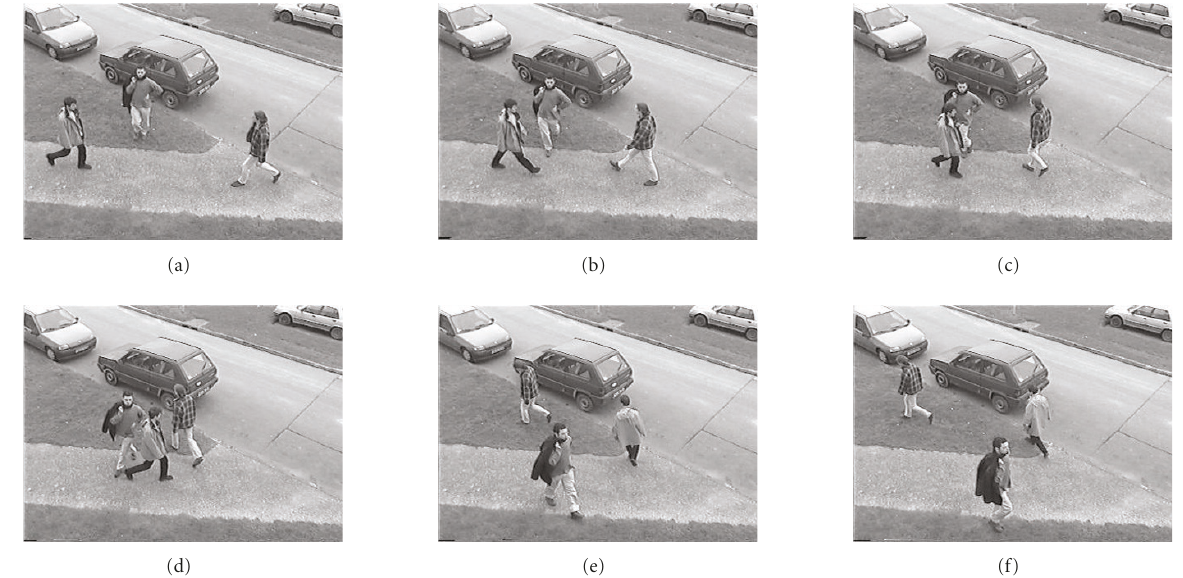
Figure 6: Image sequence with three pedestrians walking on a road side. We show the image frames at t = 9,19,26,37,67,80. Here we can see that they are walking in di ff erent directions and also cross each other at